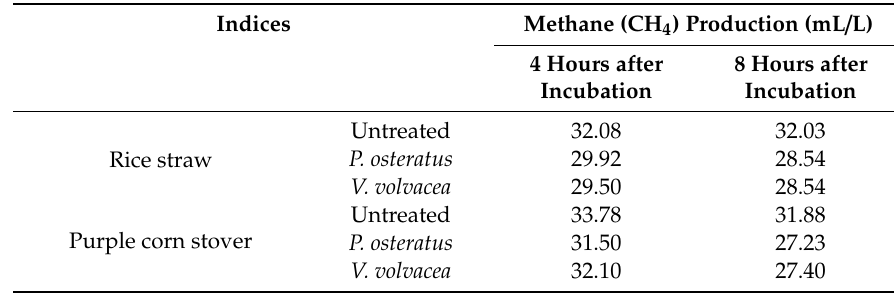
Table 6. E ff ect of roughage fermentation with white-rot fungus type on methane (CH 4 )